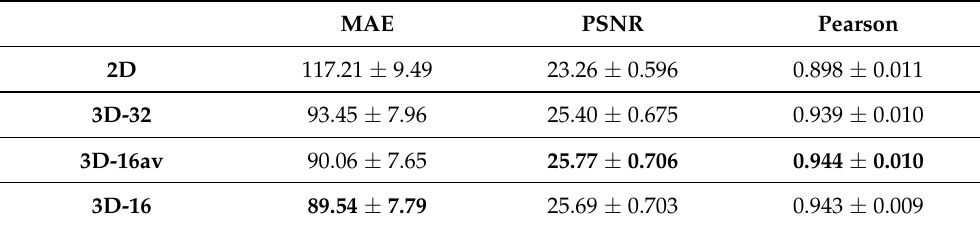
Figure 7. Head results using 3D-16 networks. Table 1. Head dataset with U-net. Mean Absolute Error, PSNR and Pearson coefficient on the head data set obtained using U-net with different convolutions and reconstructions.